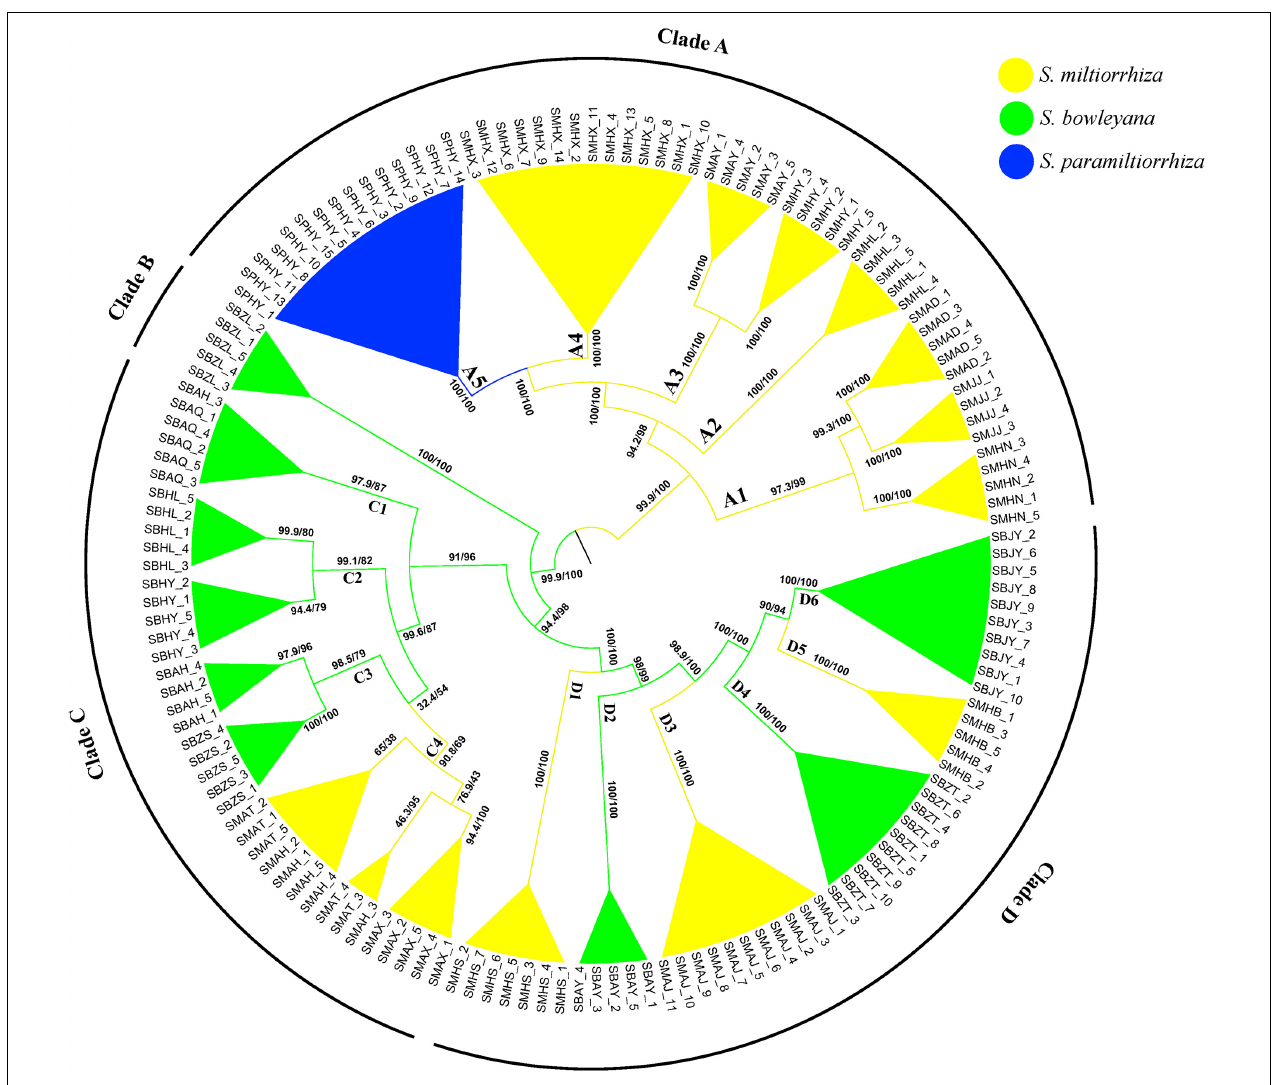
FIGURE 2 | Phylogenetic relationship between S. miltiorrhiza , S. bowleyana , and S. paramiltiorrhiza sampled populations using Maximum Likelihood methods based on SNPs. Bootstrap supports (SH-aLRT/UFBoot values) are indicated at each node. The whole tree can be divided into four major clade (Clade A, B, C, D). Subclade for each species are marked by different color, and the tips label are the individuals